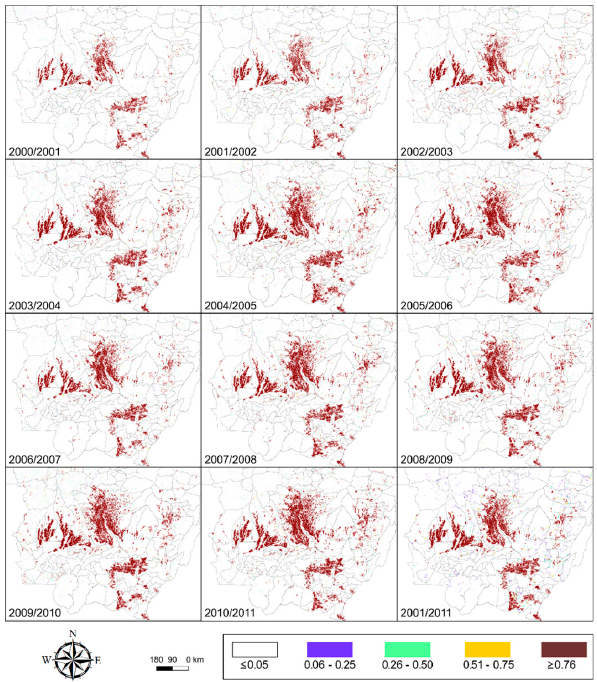
Figure 7. Binomial areal kriging prediction of the percentage of occurrence of soybean crop areas inside soybean harvested areas detected by remote sensing, per harvest period (2000/2001 to 2010/2011) and the averaged years (2001/2011).